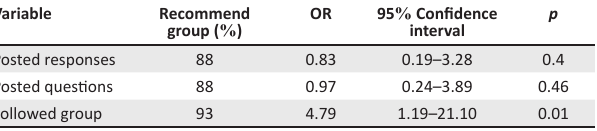
TABLE 5: Clinician recommendation of the WhatsApp group based on their level of engagement in the group ( n = 91) Variable